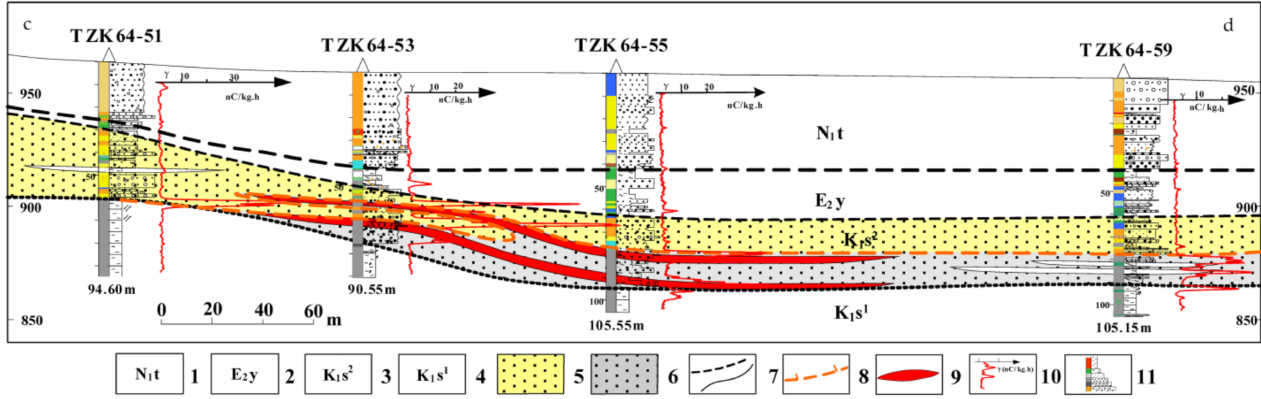
Figure 8. Geological profile of c–d in Saihangaobi uranium deposits. 1—Tongguer group. 2— Yierdingmanha group. 3—Upper part of Saihan group. 4—Bottom part of Saihan group. 5—Yellow oxidized sands. 6—Gray reducing sands. 7—Angle of the parallel unconformity boundary. 8—The oxidation front line. 9—Uranium ore bodies. 10—Gamma logging. 11—Rock particle size histogram and color